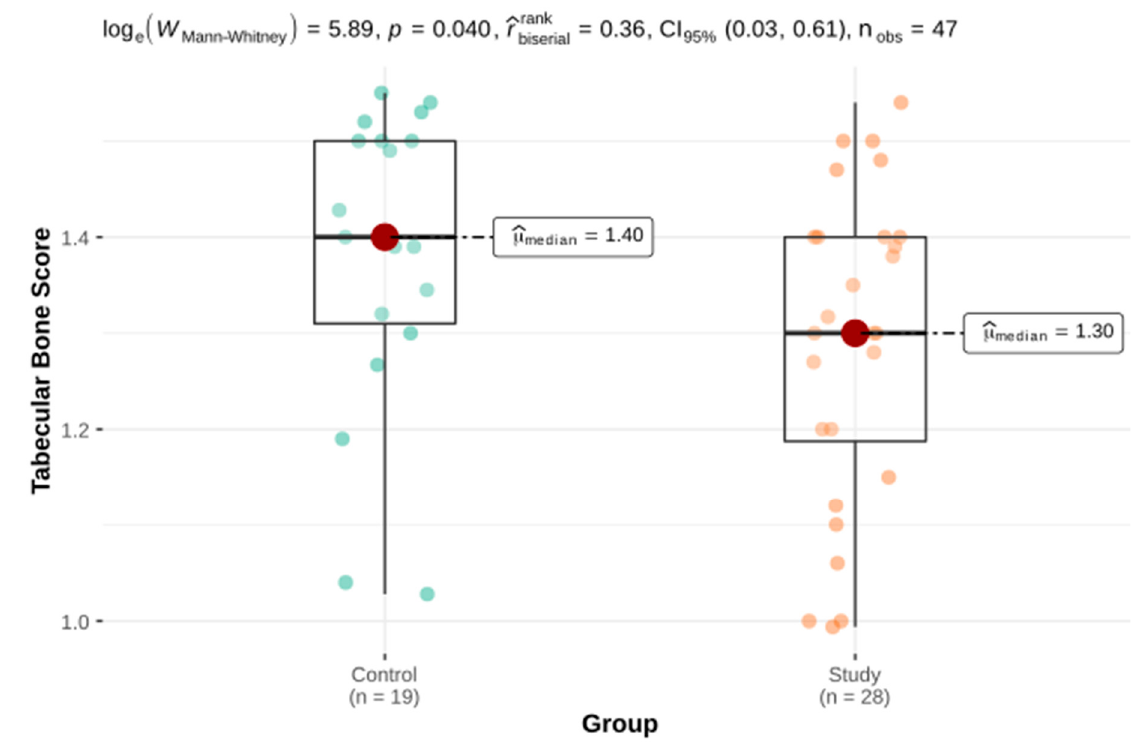
Figure 1. The TBS in the study and the control groups. TBS: trabecular bone score.